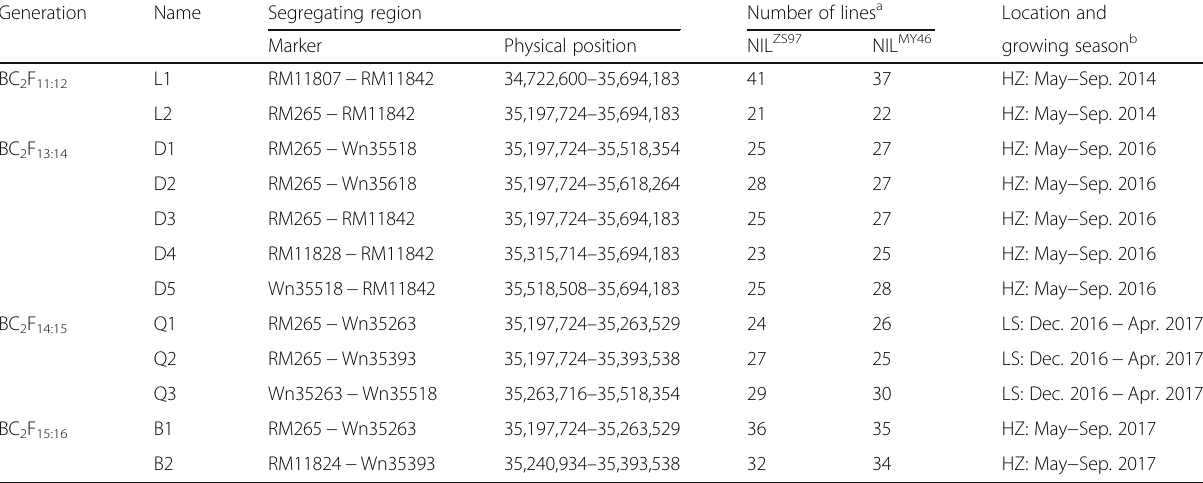
Table 1 Rice populations and field experiments